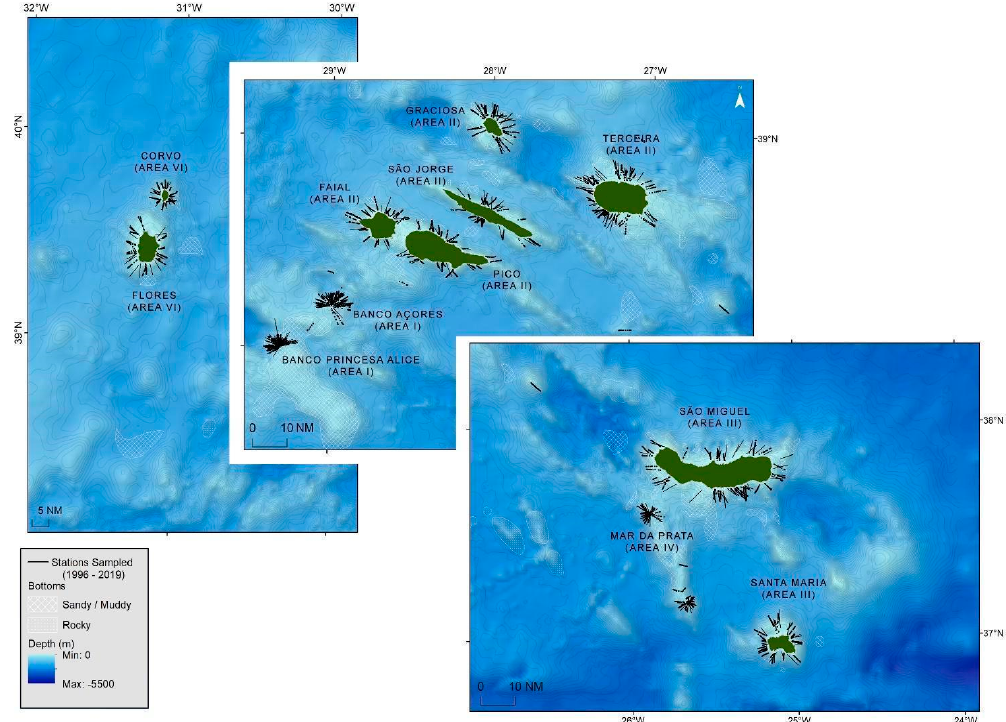
Figure 1. Azores map with bathymetry, substrate type and sampling stations from the scientific survey ARQDAÇO (1996–2019).